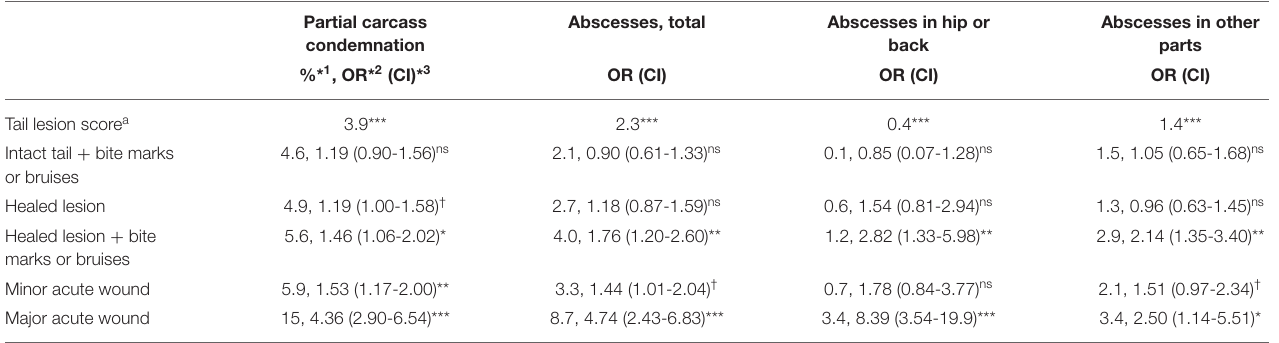
TABLE 5A | Results from logistic regressions on the association between tail lesion score, when the tail was at least 24cm ( n = 11756) and carcass condemnations as well as abscesses recorded at meat inspection. Partial carcass condemnation